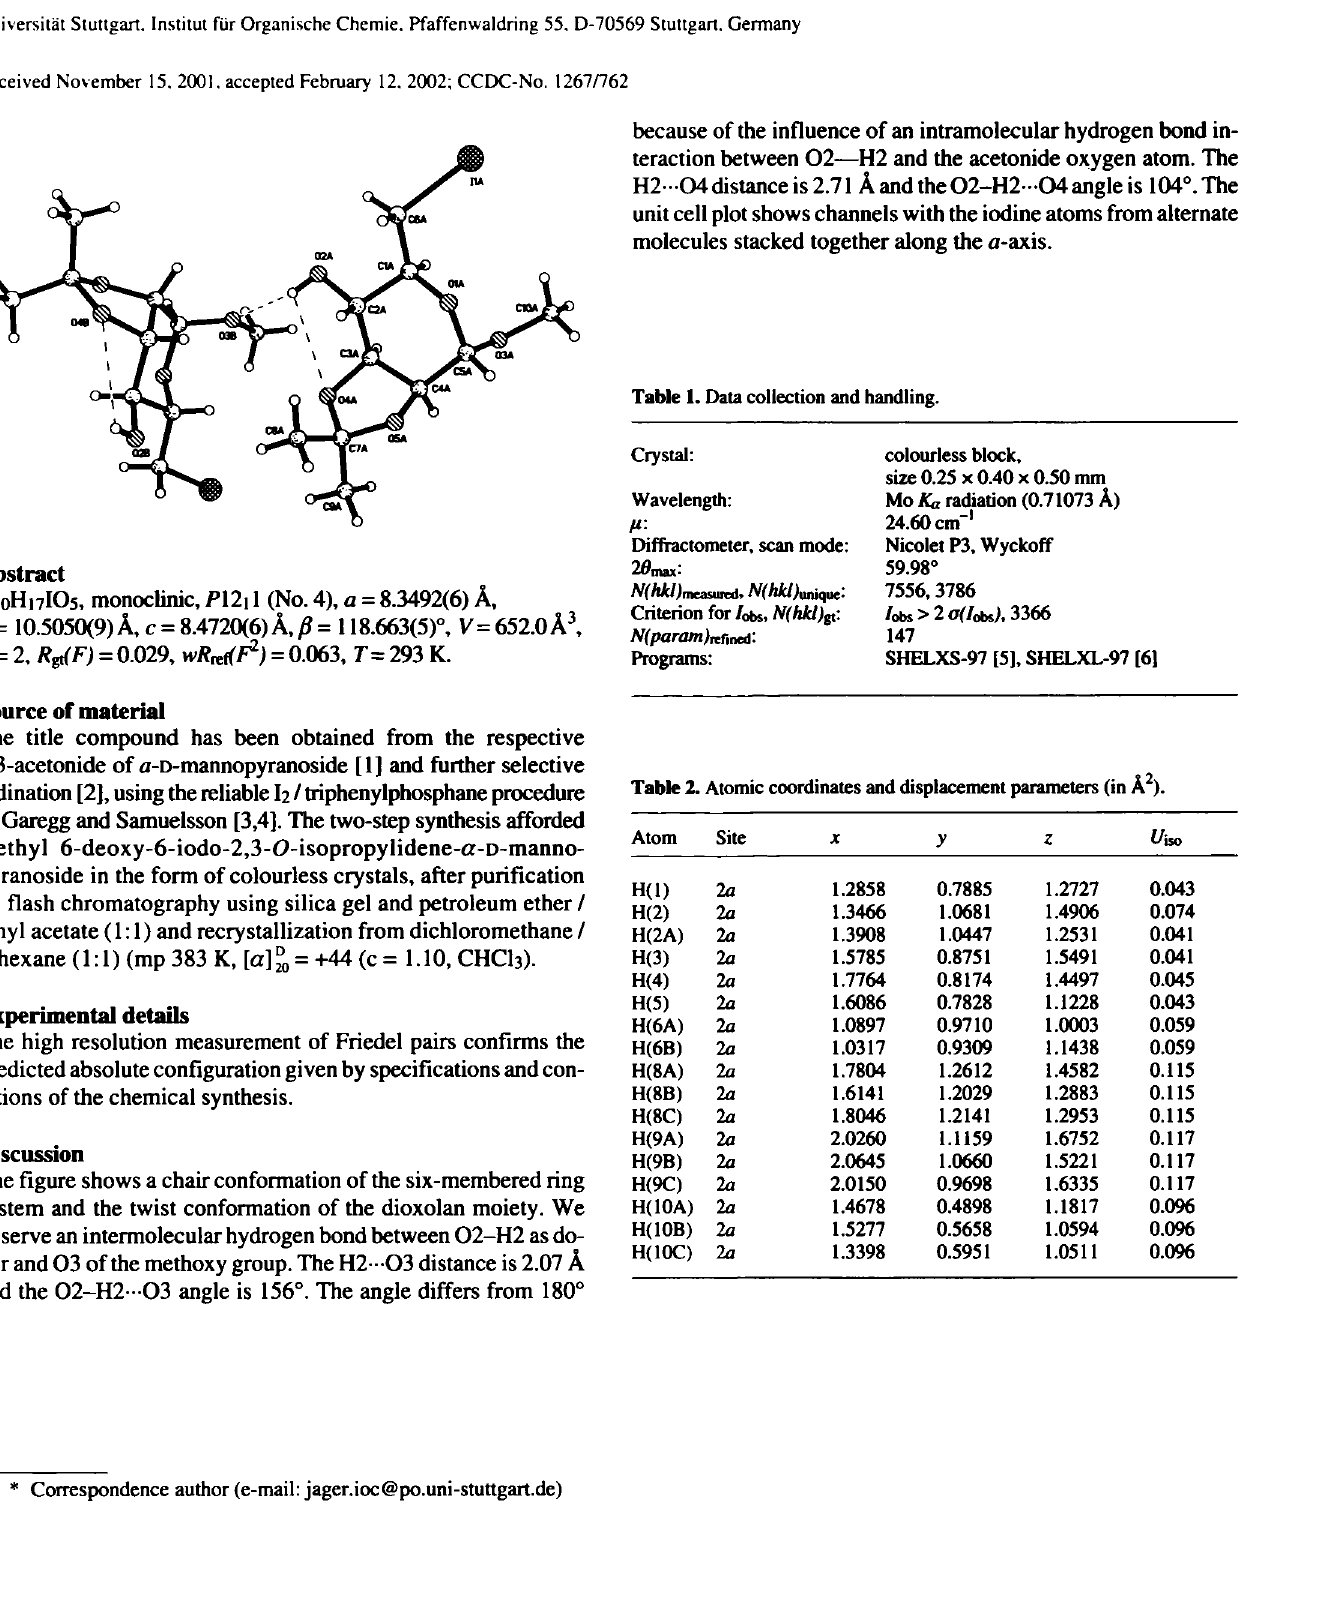
Table 1. Data collection and handling.